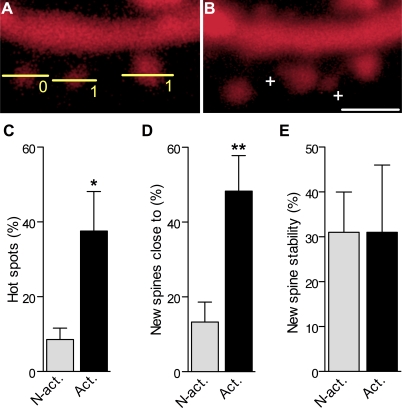
Clustering of Newly Formed Spines around Activated Synapses(A) Illustration of a dendritic segment with two spines (line scans, 1) that responded with a calcium signal to the stimulation and another spine (0) that did not.(B) Same segment imaged 24 h later showing the formation of two new protrusions (+) in close proximity (< 1.5 μm) of the activated spines (scale bar: 1.5 μm).(C) Proportion of activated and nonactivated spines that exhibited a new protrusion formed at < 1.5 μm (hot spot) within the next 48 h after TBS in seven experiments.(D) Proportion of new spines formed during the 48 h that followed TBS and appeared close to (< 1.5 μm) a nonactivated or an activated spine.(E) Stability of new protrusions measured as the proportion of protrusions formed within 5 h after TBS in close proximity to an activated or nonactivated spine and still present 48 h later.*p < 0.05; **p < 0.01, two-tailed unpaired t-test.